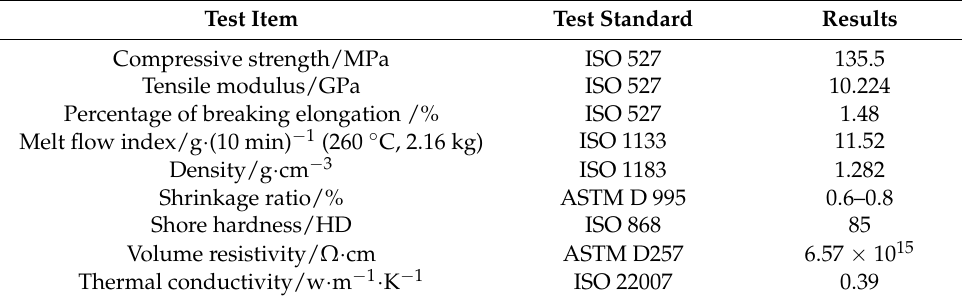
Table 1. Properties of NSSs.